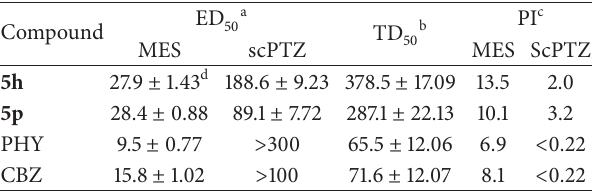
Numberofanimalsused=08;solventused:polyethyleneglycol(0.1mL,i.p.), a ED 50 —median effective dose eliciting anticonvulsant protection in 50% animals. b TD 50 median toxic dose eliciting minimal neurological toxicity in 50% animals. c PI = protective index (TD d Data in parentheses are the 95% 50 /ED 50 ). confidence